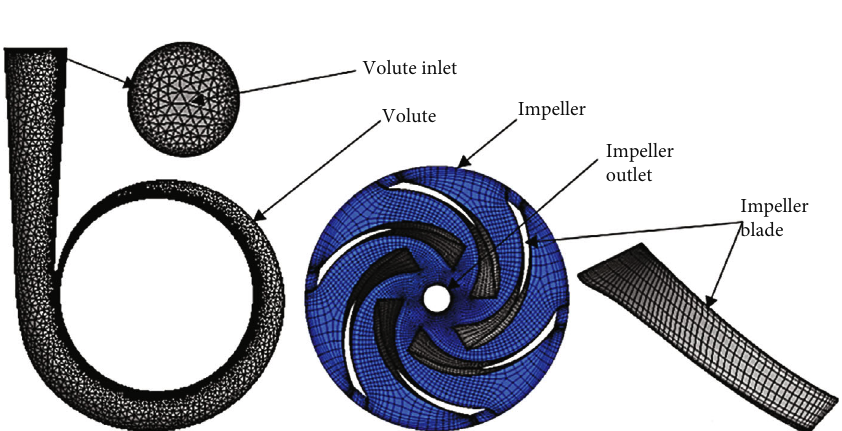
Figure 1: Mesh re fi nement in special areas.